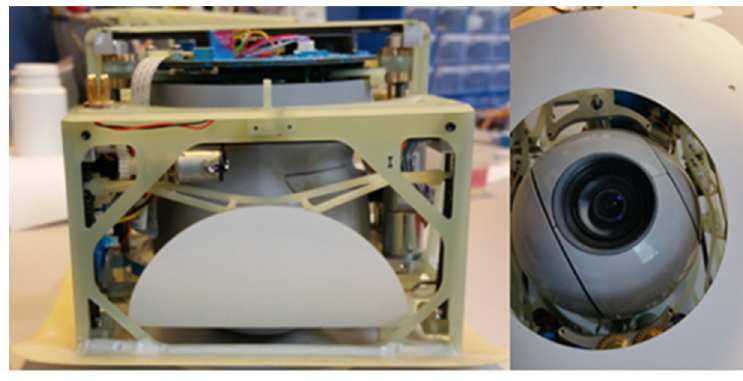
Figure 3. HIRRUS V1 payload.